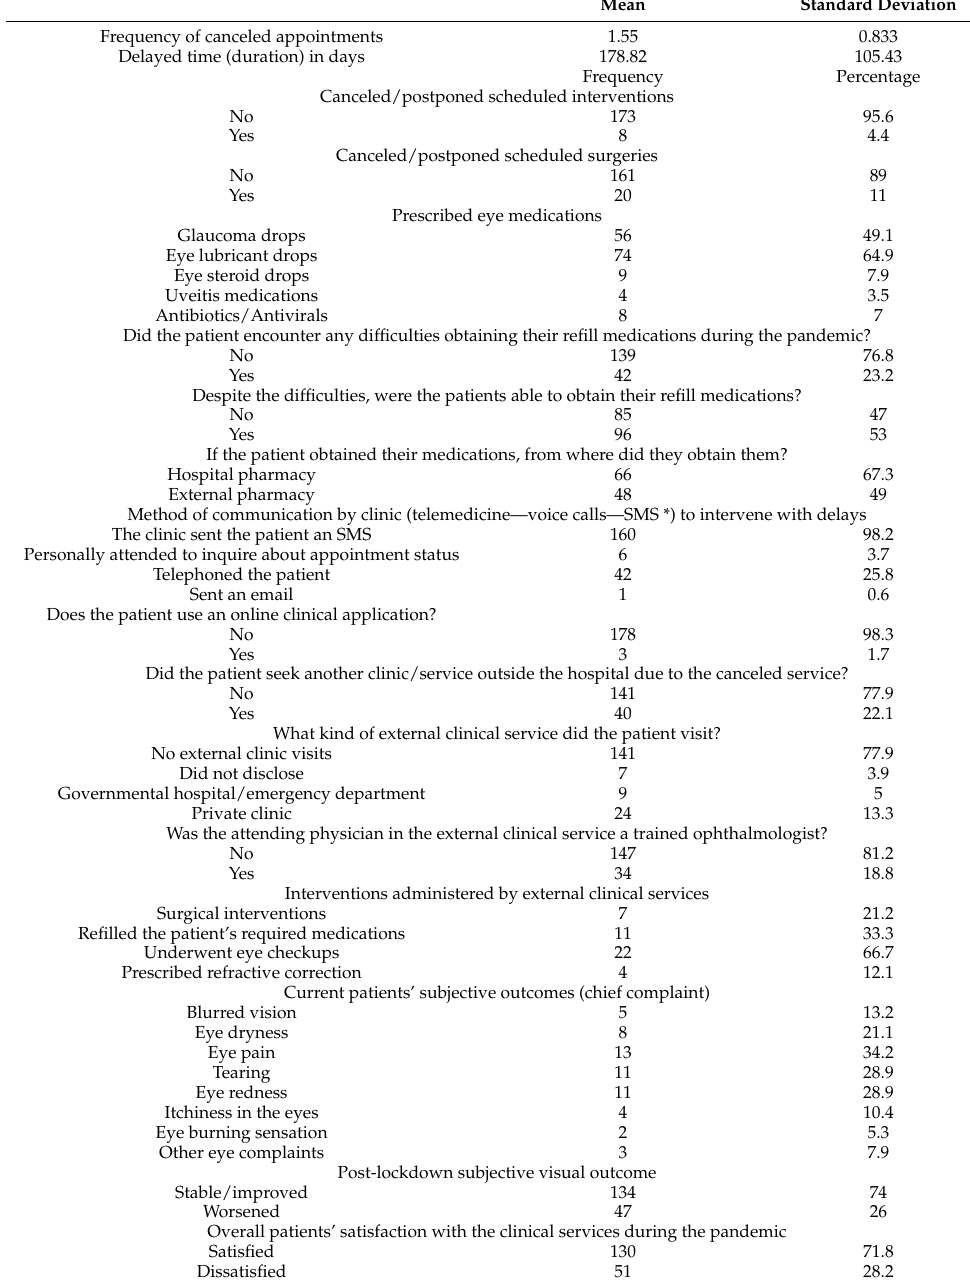
Table 2. Descriptive analysis of the patients’ ophthalmologic clinical appointment and cancellation